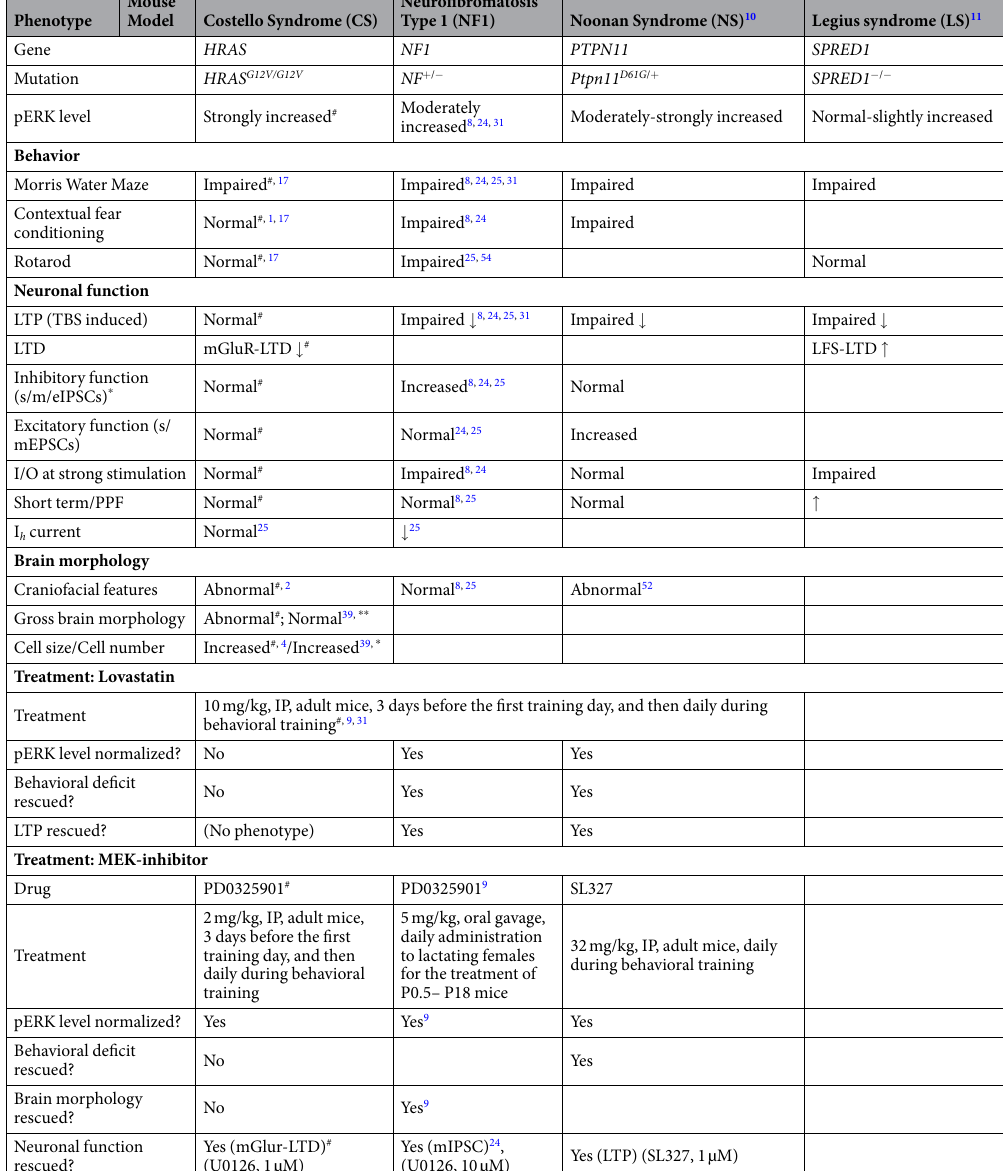
quadrants: t 14 = − 1.05, P = 0.16; between subject comparison F 1,30 = 4.20, P < 0.05; Fig. 3B). After 4 additional days of training, mutants and wild-type mice reached the platform at comparable times (Fig. 3A), after which a probe trial confirmed that both wild-type and HRas G12V/G12V animals had learned to find the position of the plat- form and showed selective spatial searching (TQ vs. OQ, HRas G12V/G12V : t 14 = − 4.64, P < 0.01; WT: t 16 = − 5,47, P < 0.01; between subject comparison, effect of genotype: F 1,30 = 0.42, P = 0.79; Fig. 3C). These results indicate that HRas G12V/G12V mutant mice in the C57BL/6 background have a spatial learning impairment that can be over- come with additional training. In order to assess the cognitive flexibility of HRas G12V/G12V mice, the platform was then relocated to the oppo- site quadrant for 5 additional training days, beginning on day 10. A probe trial on day 14 revealed that wild-type mice had successfully learned the new platform position (TQ vs. OQ: t 9 = − 3.89, P < 0.01), whereas HRas G12V/G12V mice again showed no preference for the target quadrant (TQ vs. OQ: t 7 = − 1.18, P = 0.14; between subject